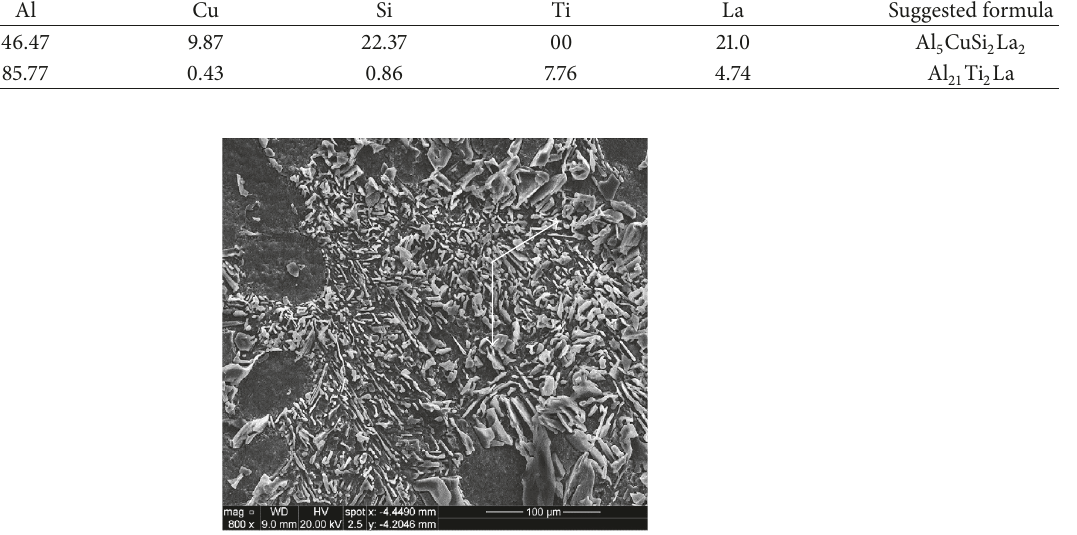
Figure 12: Secondary electron image showing Si particles distribution within a colony in the TES alloy. Note the difference in Si particle size in going from the centre to the periphery, white arrows.